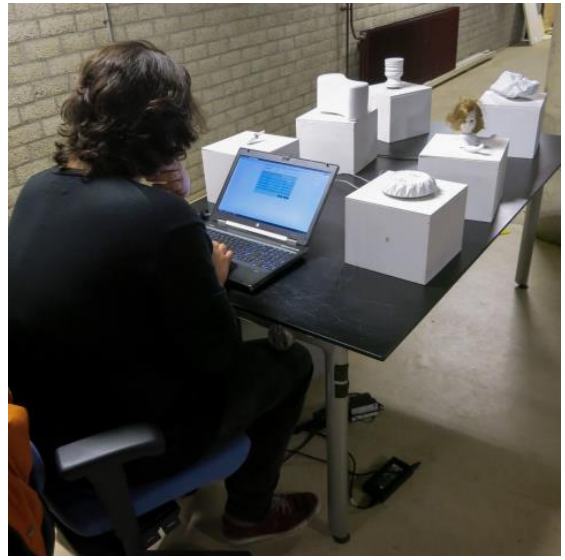
Figure 10. User study setup with the six prototypes and a participant filling out a